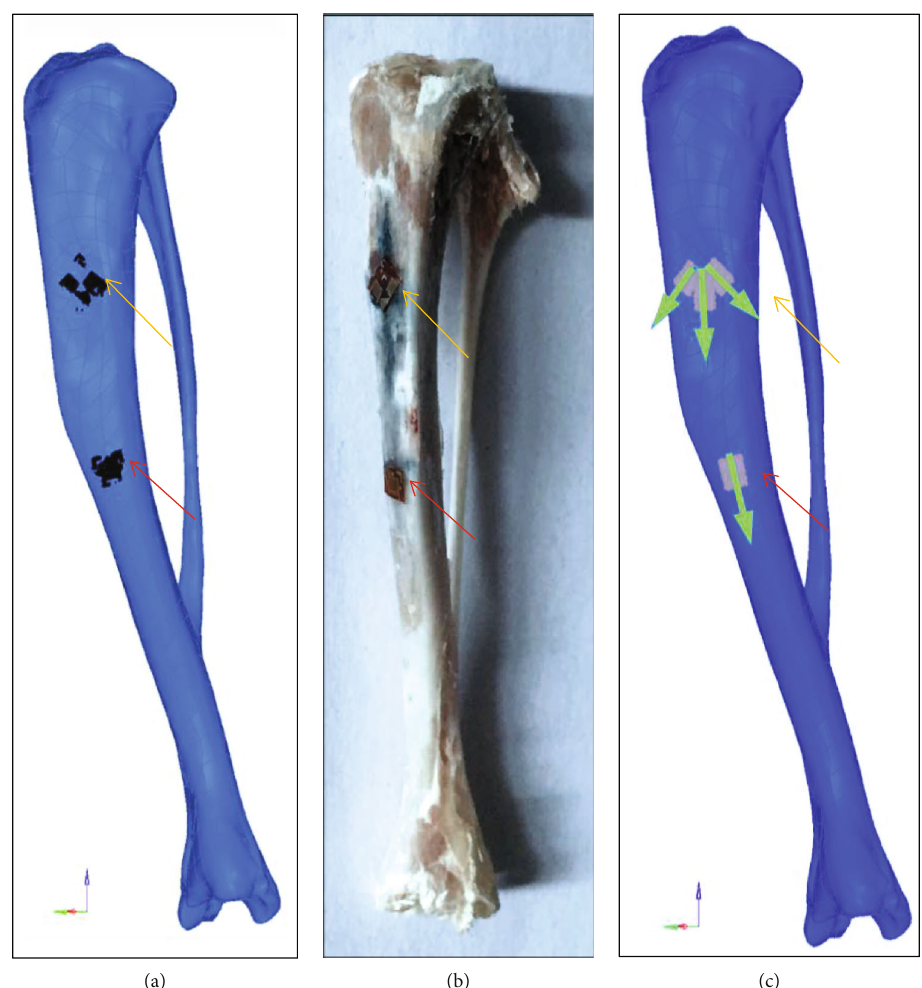
Figure 8: Regions of strain gauges and local coordinate system: (a) regions of strain gauges scanned by micro-CT; (b) regions of strain gauges on the samples; (c) node sets of strain gauges and local coordinate systems. Red arrow: single-element strain gauge; yellow arrow: strain gauge rosette; green arrow: z -axis of the local coordinate